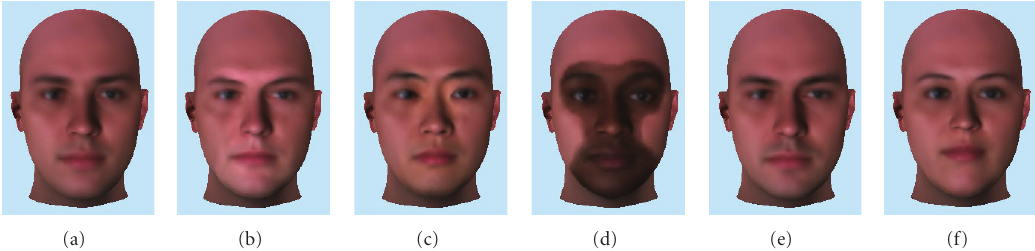
Figure 17: Adapting the face to population groups: (a) average face; (b), (c) and (d) synthesized faces with the ethnicity of Caucasian, Mongolian and Negroid, respectively; (e) and (f) synthesized male and female faces,